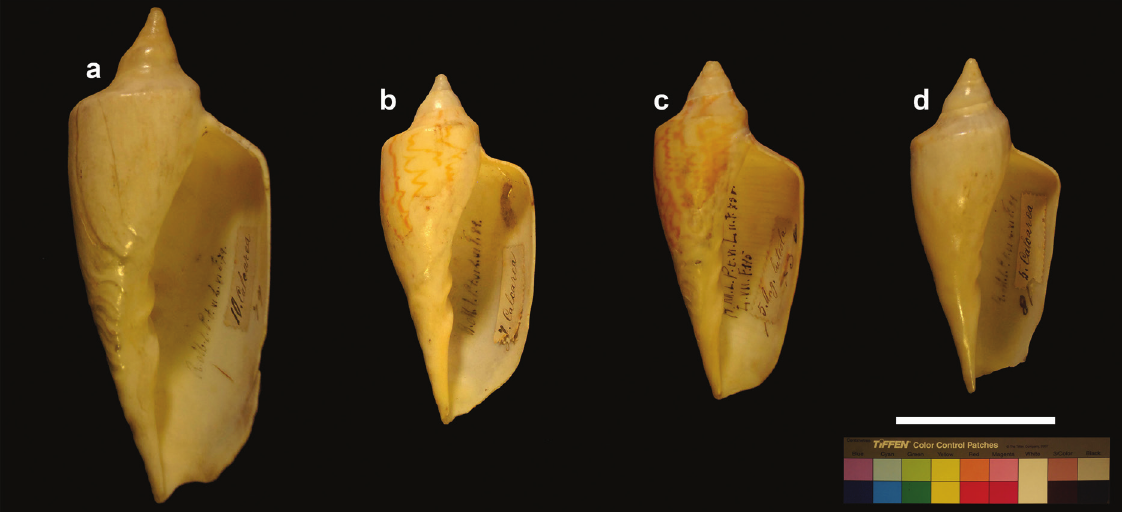
Figure 21. Voluta angulata luteola , figured by Lahille (1895). See references on Table 7. Scale bar: 5 cm.